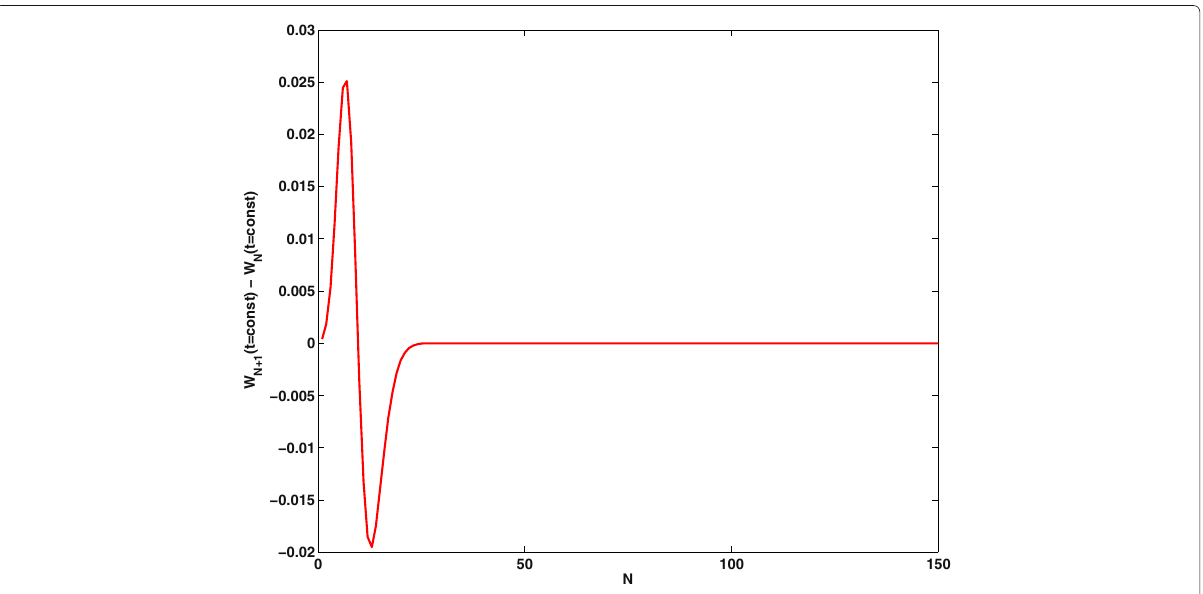
Fig. 4 Population inversion difference W N + 1 ( t = const ) − W N ( t = const ) vs upper boundary N in the sum (3)